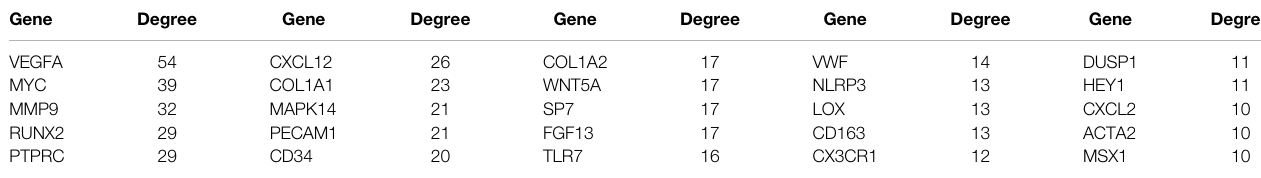
TABLE 4 | List of hub genes and corresponding connectivity